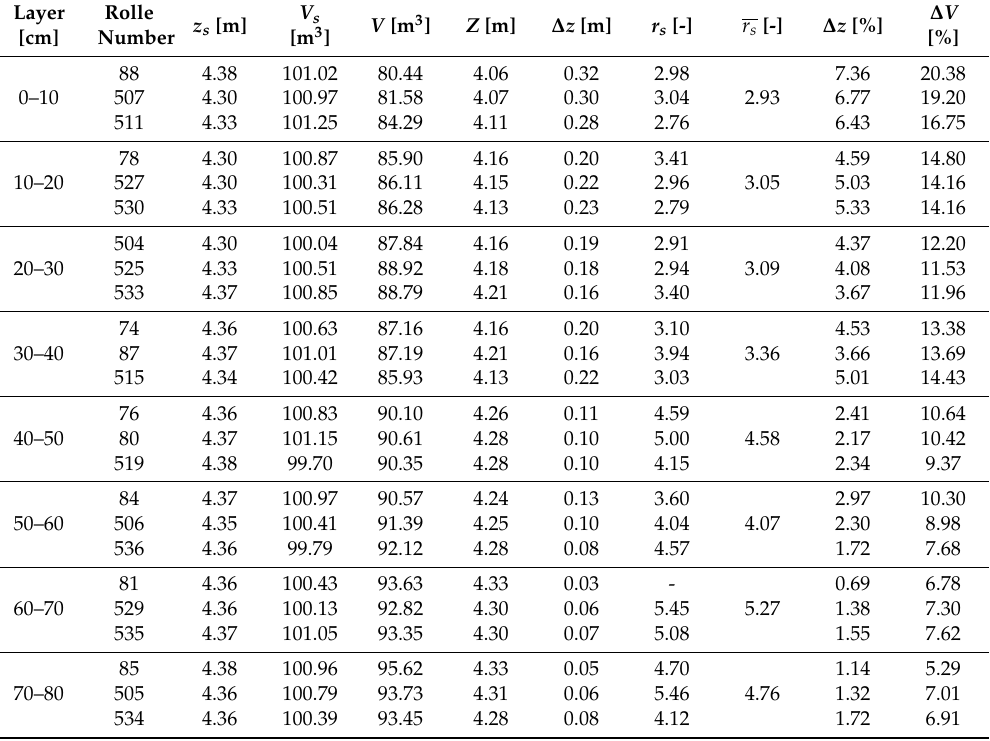
Table 1. Soil sample measurements and calculation of r s in the Michalovce locality.